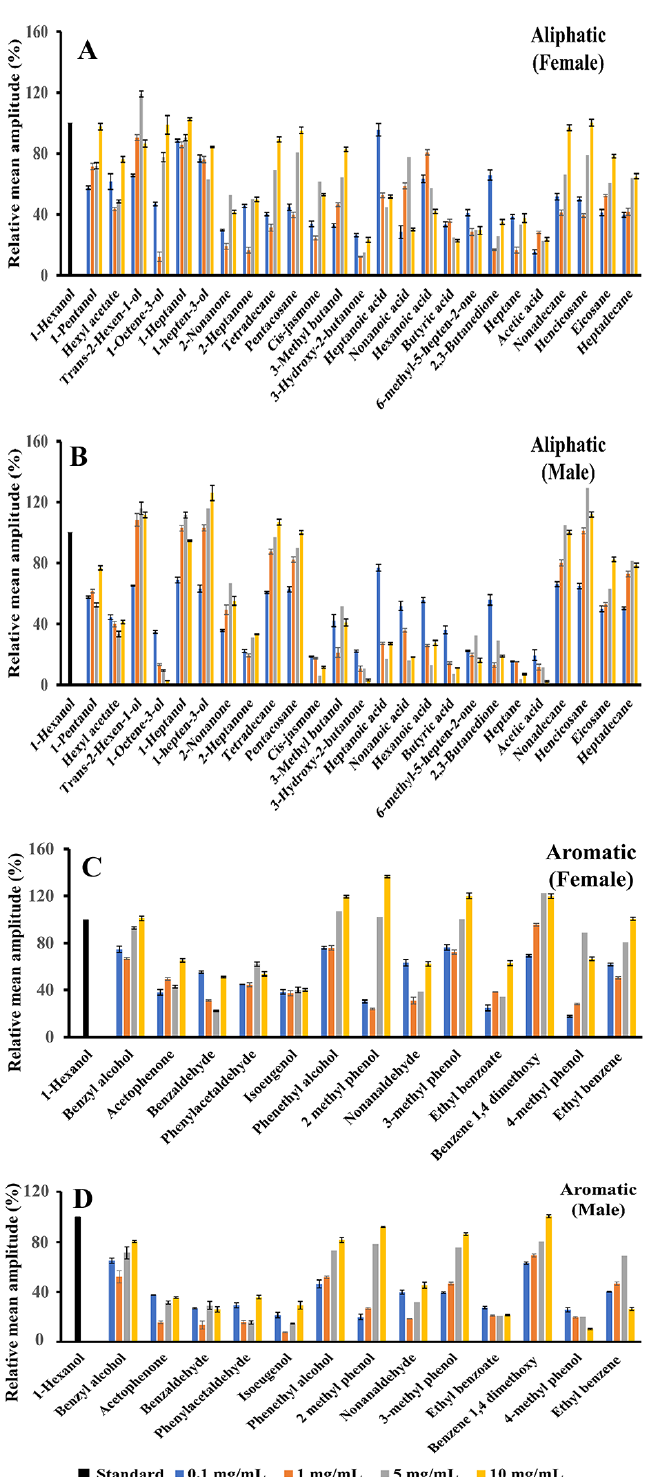
Figure 3. Mean normalized electroantennography (EAG) responses for aliphatic ( A , B ) and aromatic ( C , D ) compounds in female and male Aulacophora foveicollis to plant volatiles at 0.1, 1, 5.0 and 10 mg/mL concentration. Males elicited maximum changes of 100.50 ± 1.25% in EAG amplitudes with 1,4, dimethoxybenzene at 10 mg/mL, while the other readings followed as 80.25 ± 1.11%, 69.14 ± 0.61% and 62.99 ± 1.02% at 5, 1 and 0.1 mg/mL concentrations,